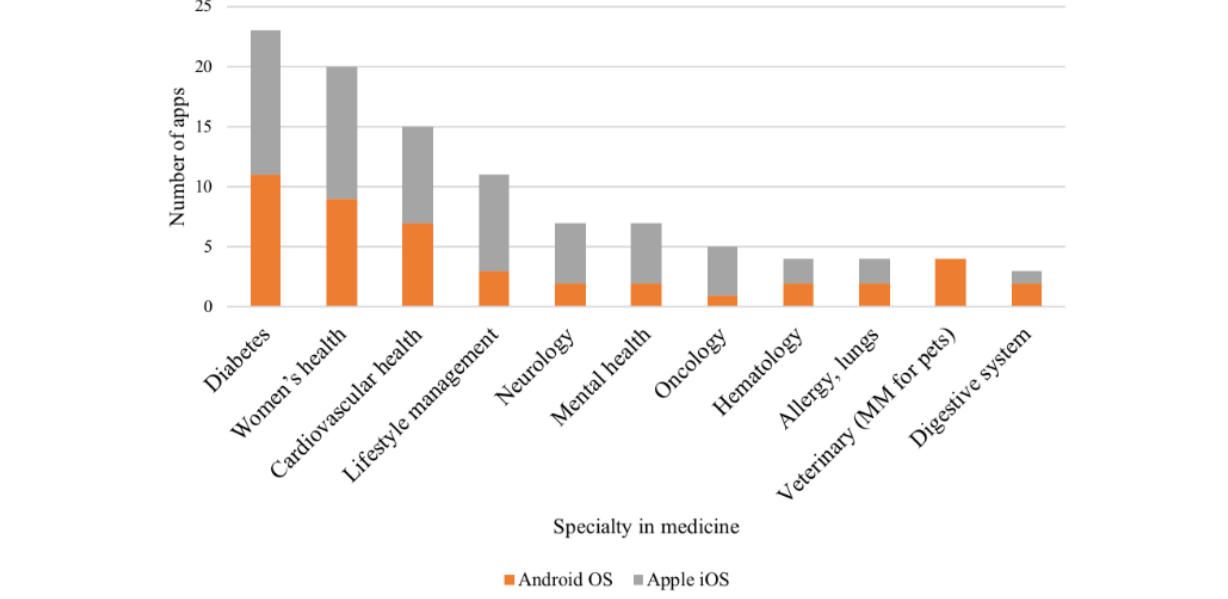
Figure 3. Distribution of medication management (MM) apps focusing on certain medical conditions or specialties in